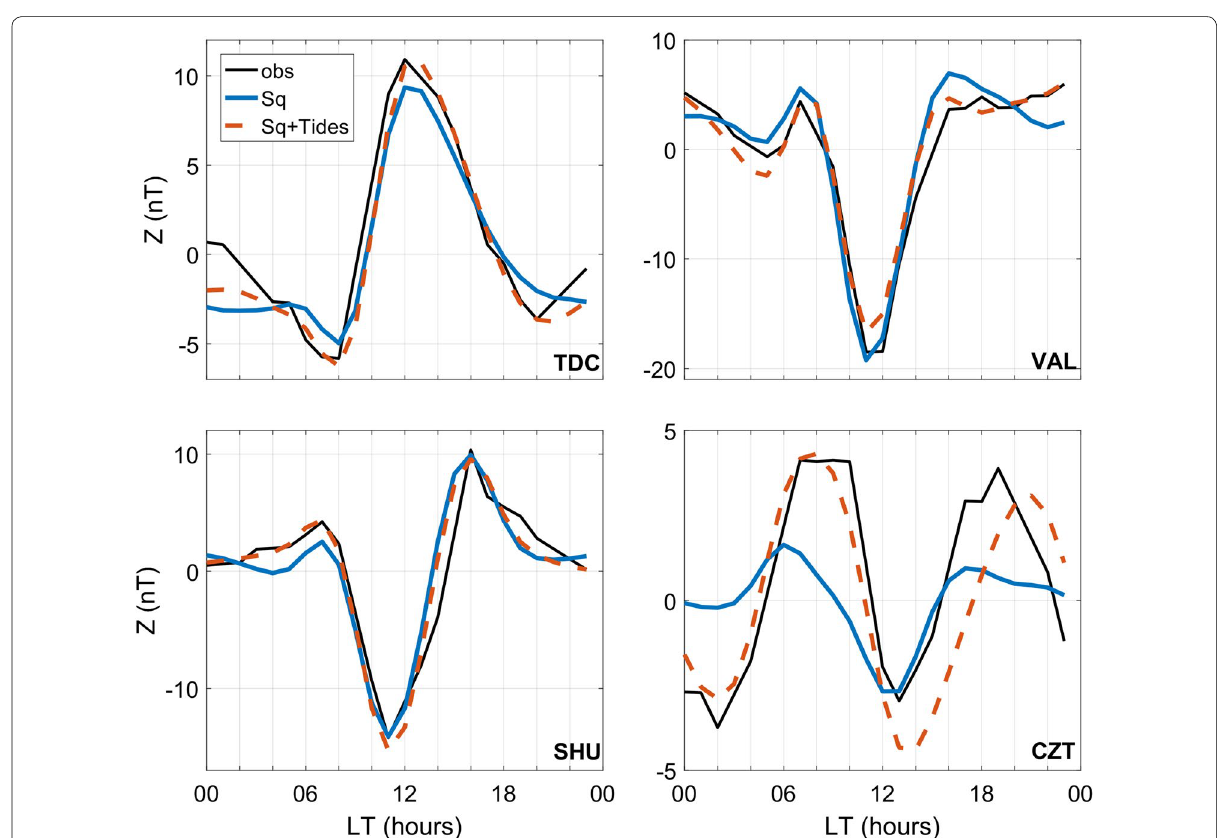
Fig. 5 Vertical components of the observed and modeled Sq and Sq Valentia (VAL, Ireland), Shumagin (SHU, Alaska), and Crozet Archipelago (CZT)